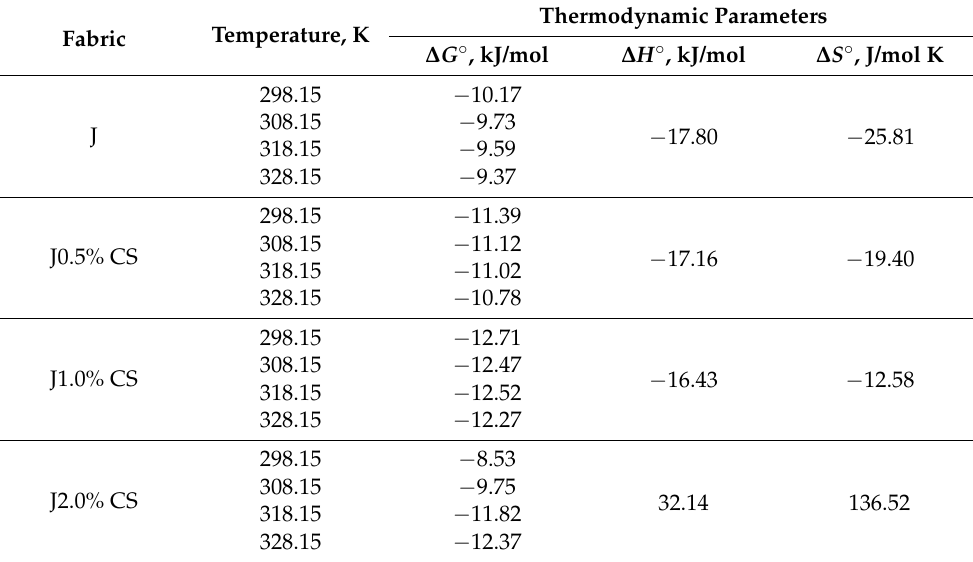
Table 3. Thermodynamic parameters for RO 16 adsorption onto investigated adsorbents. Thermodynamic Parameters Fabric Temperature, K ∆ G ◦ , kJ/mol ∆ H ◦ , kJ/mol ∆ S ◦ , J/mol K